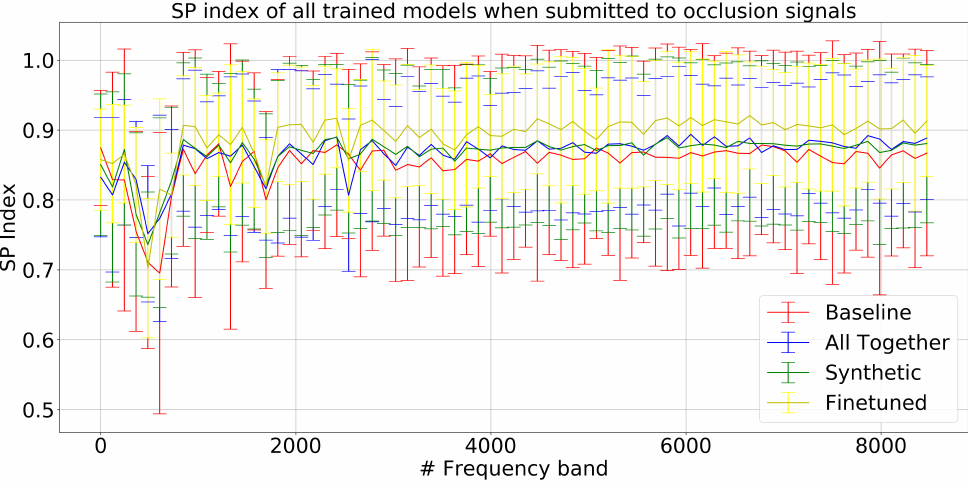
Figure 18. Efficiency considering frequency band